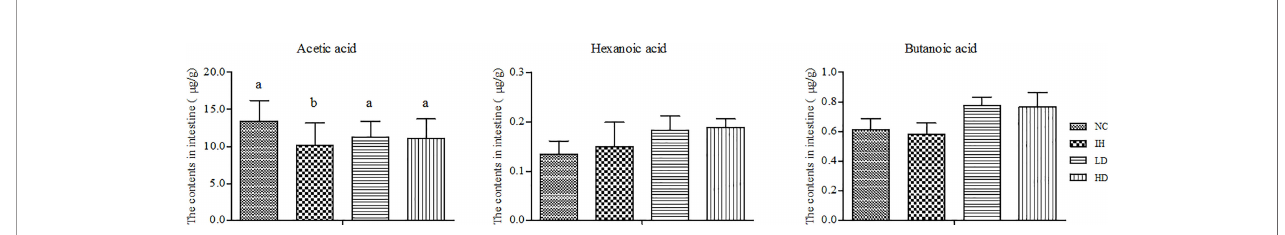
FIGURE 4 | Changes of intestinal short-chain fatty acid (SCFA) contents after dietary 1% and 2% of CLNT in IHNV-infected rainbow trout ( P <0.05). Different letters indicated signi fi cant differences among the groups.